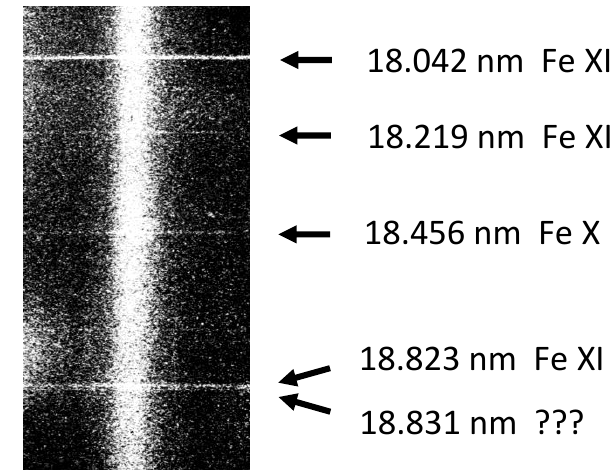
Figure 6: An excerpt of the solar XUV spectrum with iron Fe X and Fe XI emissions recorded on 29 th April 1971 (Schweizer and Schmidtke, 1971, © AAS, reproduced with permission).